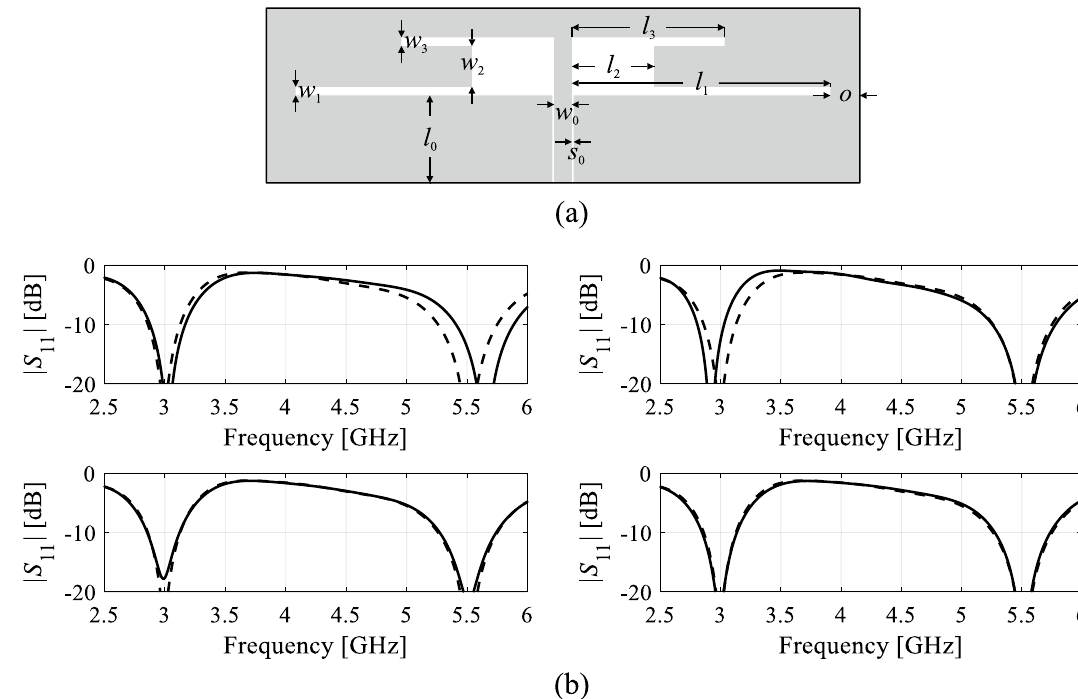
Figure 1. Dual-band dipole antenna and its response variability: ( a ) antenna geometry, ( b ) EM-evaluated reflection characteristics | S 11 ( x , f )| (- - -) and | S 11 ( x + h v ( j ) , f )| (—) for j = 1, 2, 3, and 4 (from top-left to